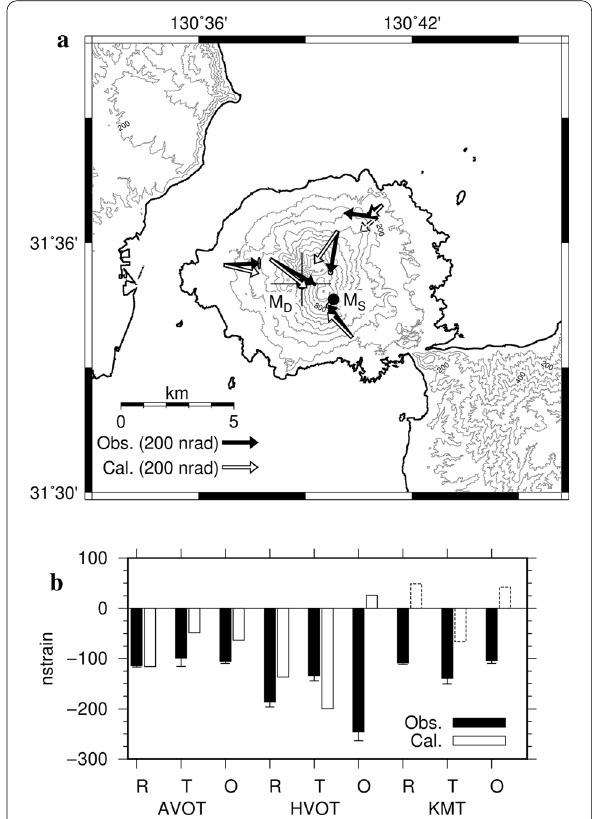
Fig. 5 Same as Fig. 4, but for phase 2 (22:10–24:00), excluding the data of KMT and assuming dual spherical sources (source M S obtained for phase 1 and an additional deeper spherical source M D ). The depths of the sources M S and M D are 0.1 km bsl and 3.3 km bsl, respectively. The error bar is the 99% confidence level estimated by an F -test (Árnadóttir and Segall 1994)